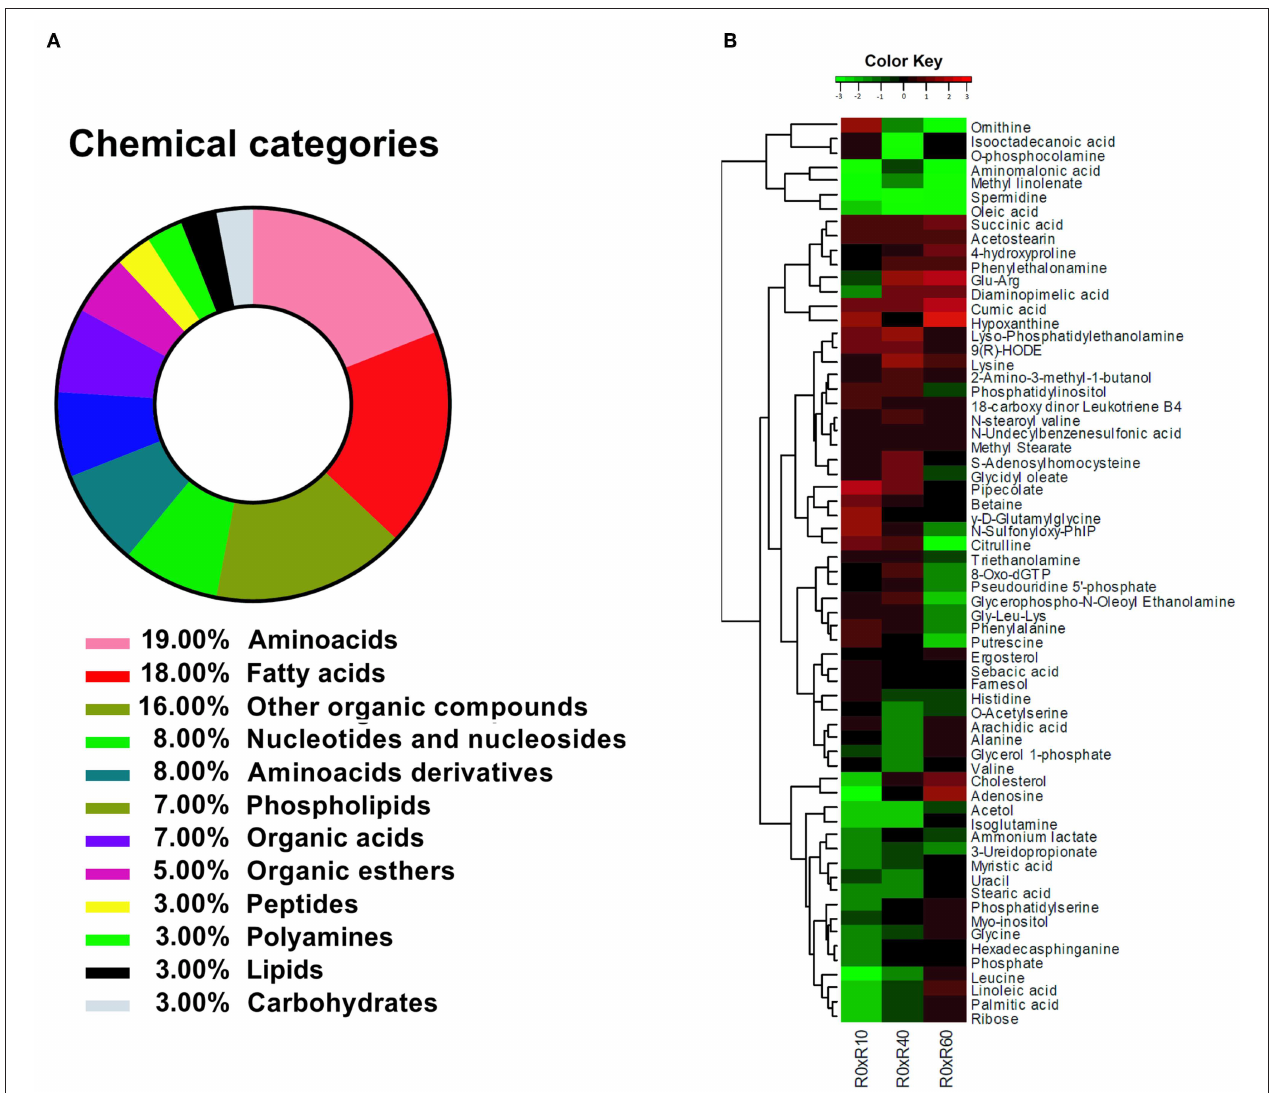
FIGURE 4 | Identification of L. amazonensis metabolites’ changes during SIVP. (A) Biochemical categories for the identified metabolites in L. amazonensis attenuation process after SIVP, identified by multiplatform metabolomic fingerprint approach. Metabolites were classified according to their chemical category by MBRole online software. (B) Heatmap showing confirmed or putatively identified metabolites in log2-scale fold change. To obtain a Kinect metabolite profile, two intermediary strains were included in this analysis, R10 and R40 (10 and 40 SIVP, respectively). The dendogram shows the fold changes behavior for each metabolite among all metabolites (metabolome), except for Proline, which extrapolated the fold change for the majority of the metabolites and did not fit into the scale. Metabolites’ fold changes were calculated by comparing the ionic abundance average (in Log 2 ) from each metabolite belonging from each attenuated lines (R10, R40, and R60) to the virulent one (R0). The Values varied from − 3.0 (green) to 3.0 (red). Non-expressive fold changes (values next to zero) were shown in black. The heatmap were generated by the R x 64 3.1.3 software, using the gplots/heatmap2